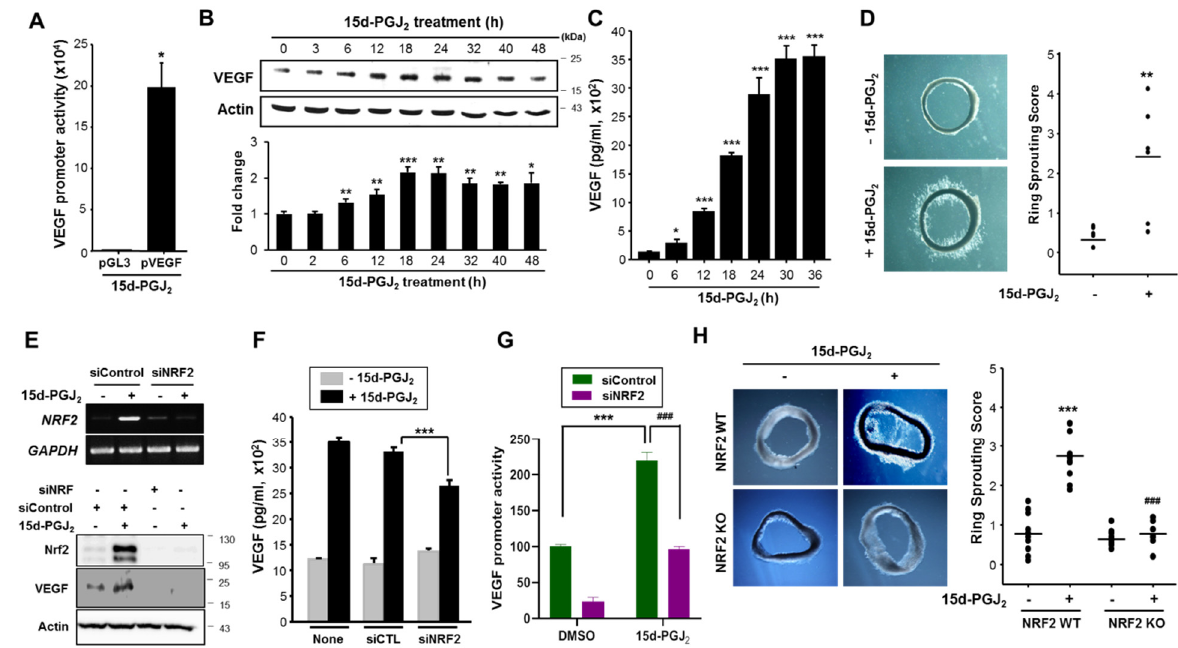
Figure 3. NRF2 mediates 15d-PGJ 2 -induced vascular endothelial growth factor (VEGF) expression and angiogenesis. ( A ) The transcriptional activity of VEGF was measured by the luciferase reporter gene assay. After transfection with the VEGF-luciferase construct, MCF-7 cells were treated with 15d-PGJ 2 (30 µ M) for 12 h. * p < 0.05, significantly different compared to empty vector-transfected control. ( B ) MCF-7 cells were treated with 30 µ M of 15d-PGJ 2 and incubated for indicated time periods. Protein extracts were separated by sodium dodecyl sulfate polyacrylamide gel electrophoresis (SDS-PAGE), and Western blot analysis was conducted for detecting the expression of VEGF protein. Data are means ± SD. * p < 0.05, ** p < 0.01, and *** p < 0.001, significantly different compared to control. ( C ) An enzyme immunoassay was conducted to measure VEGF production by 15d-PGJ 2 in MCF-7 cells. * p < 0.05 and *** p < 0.001, significantly different from vehicle control. ( D ) Aortic segments were harvested from SD rats (n = 6 per group). Aorta in matrigel was treated with 1 µ